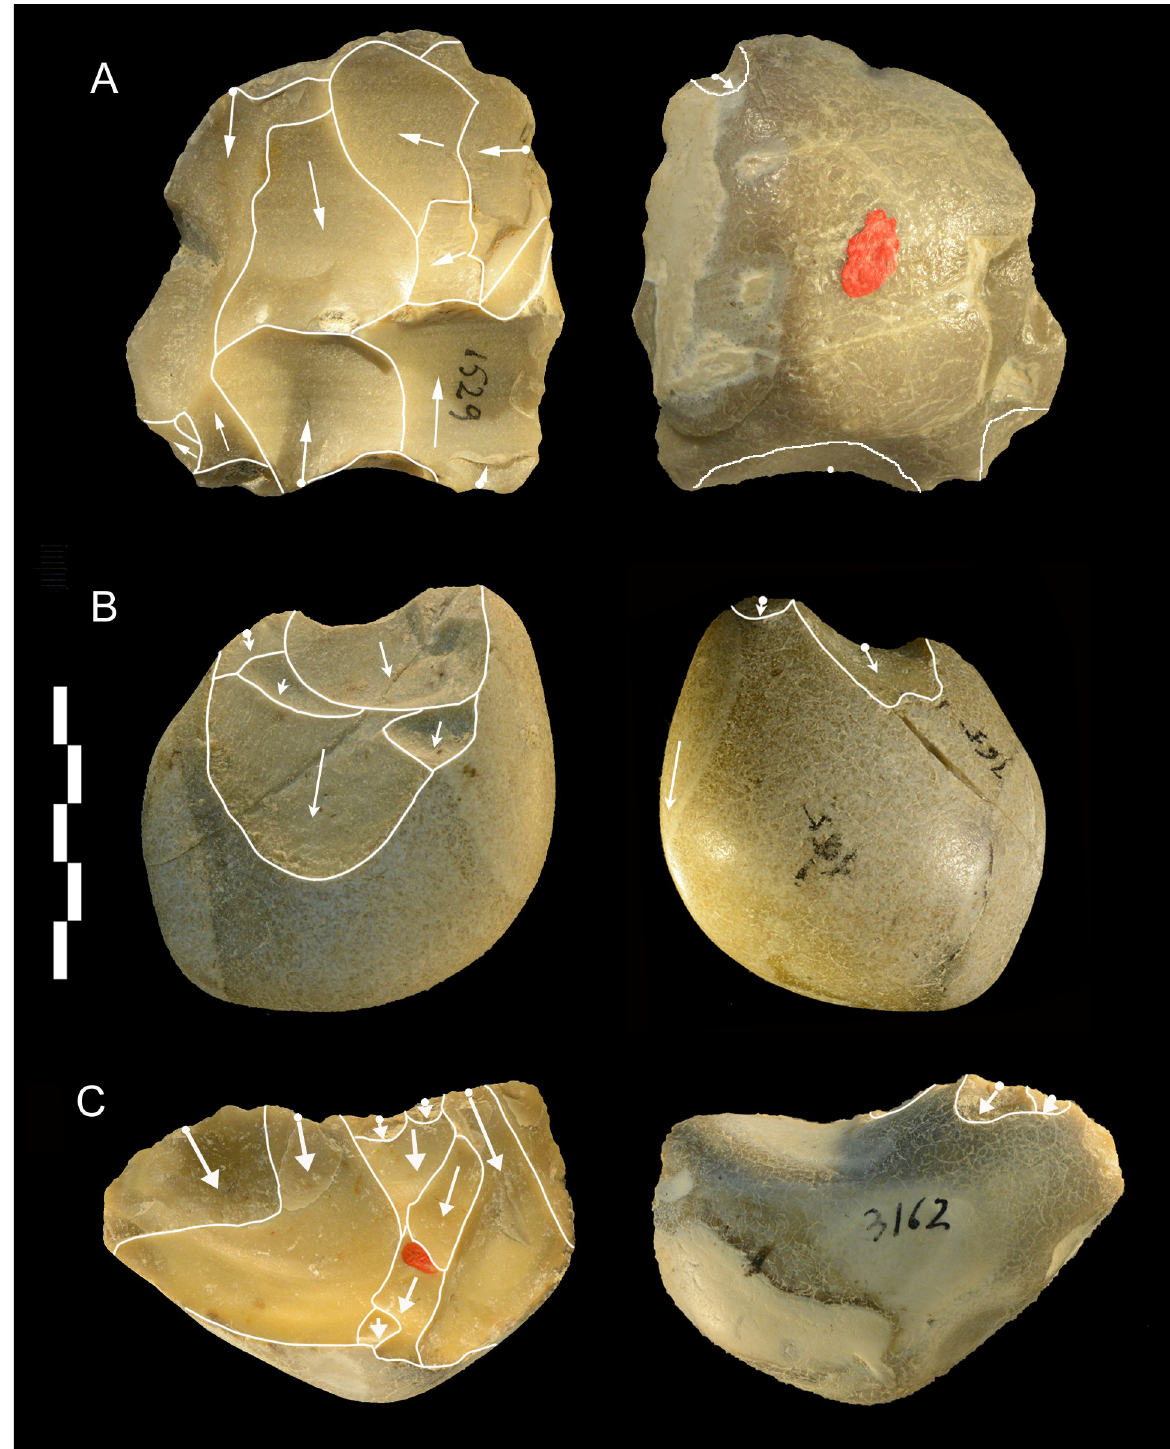
Fig 19. Castel di Guido lithics. Cores, A and C of flint, B of chert. All three have one debitage surface, A is centripetal, B and C are unidirectional. Catalogue numbers 1529, 165, 3162. Scale bar 5 cm.